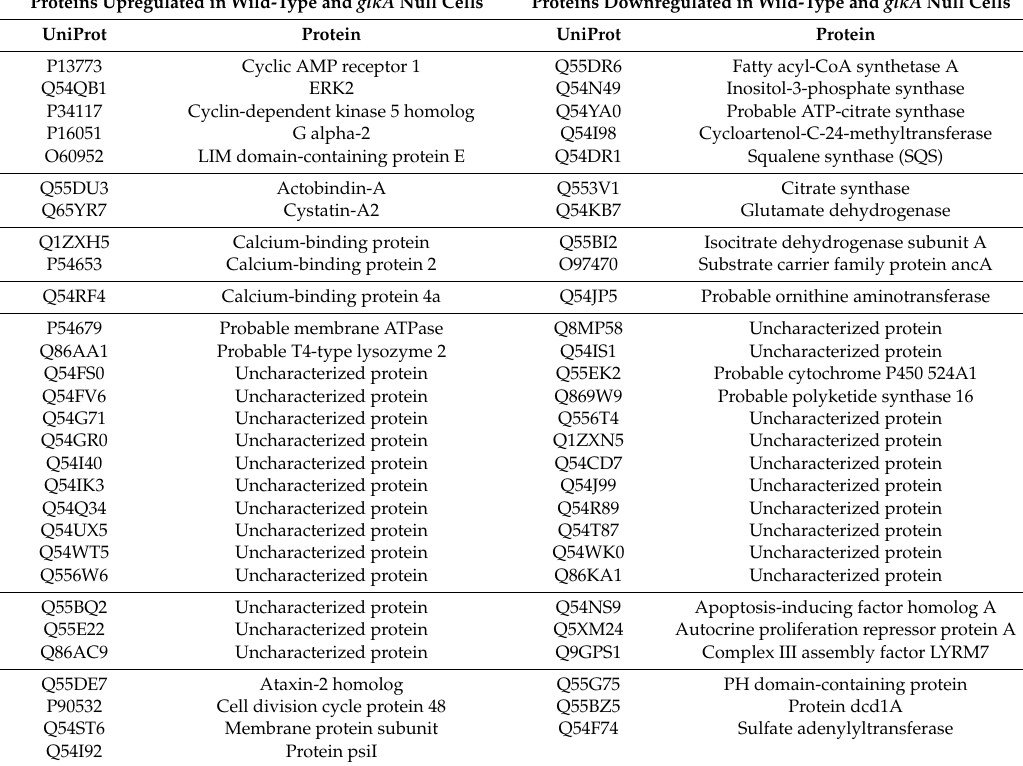
Table 1. Top 57 proteins whose level changes overlapped in both AX2 and glkA null cells. Out of the statistically significant 57 proteins, 29 are upregulated (left panel) and 28 are downregulated (right panel) in developed versus vegetative cells. UniProt IDs and protein names, if available, are shown. Color code group proteins based on their biological classification; in the left panel from top to bottom: cAMP-pathway proteins, cytoskeletal, Ca-binding, uncharacterized and other proteins. In the right panel from top to bottom: Proteins involved in lipid metabolism, mitochondrial (including three uncharacterized: Q54JP5, Q8MP58, and Q54IS1), uncharacterized and other